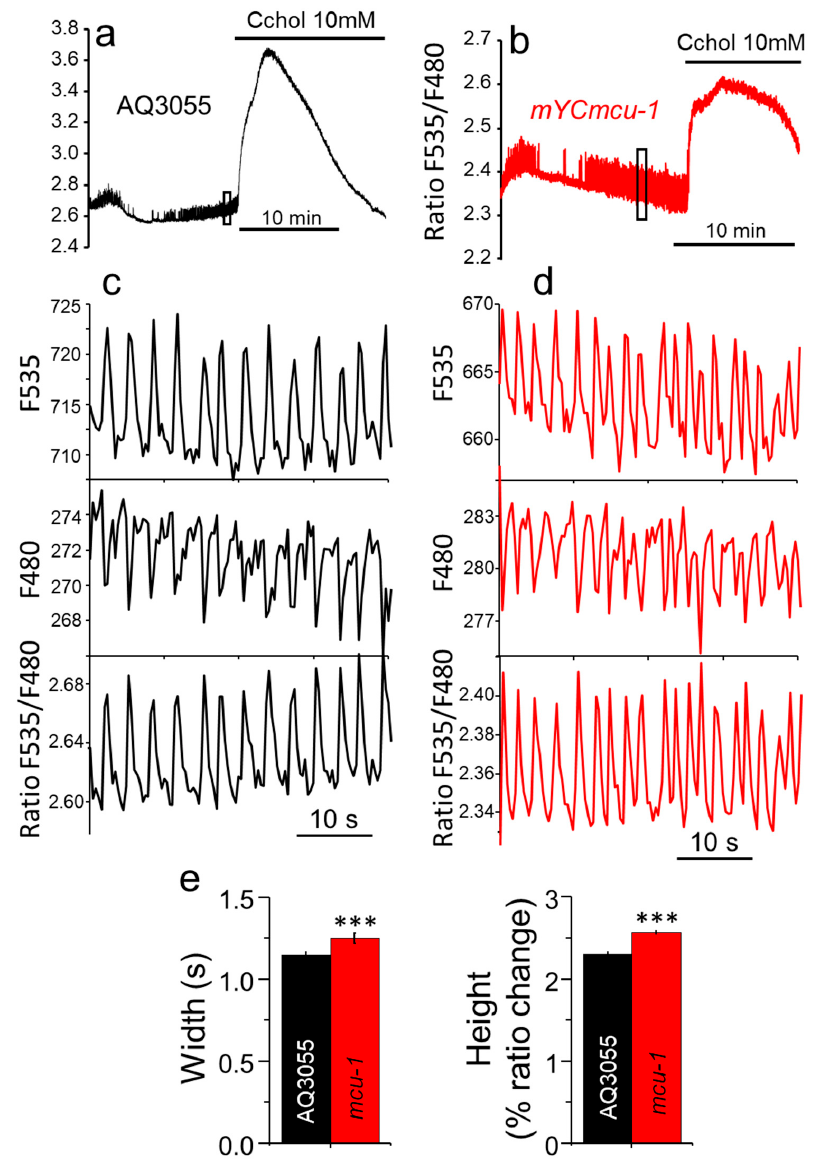
Figure 1. Mitochondrial [Ca 2 + ] dynamics in the AQ3055 and mYCmcu-1 strains. Panels a and b show typical records of fluorescence ratio obtained in the AQ3055 control strain (panel ( a )) and the mYCmcu-1 mutant strain, clone #1 (panel ( b )). When indicated, carbachol (Cchol) was added to the chamber to reach a final concentration of 10 mM. The rectangles in the traces correspond to the region that has been amplified in panels c and d. Panels c and d show the traces corresponding to the two individual F535 and F480 fluorescences (in arbitrary units), and the F535/F480 ratio, both for the AQ3055 strain (panel ( c )) and for the mYCmcu-1 strain (panel ( d )). Panel ( e ) shows the mean peak width and mean peak height obtained in each strain by averaging data obtained from 8 AQ3055 worms (2015 peaks) and 6 mYCmcu-1 worms (1183 peaks). ***, p < 0.001, ANOVA test.